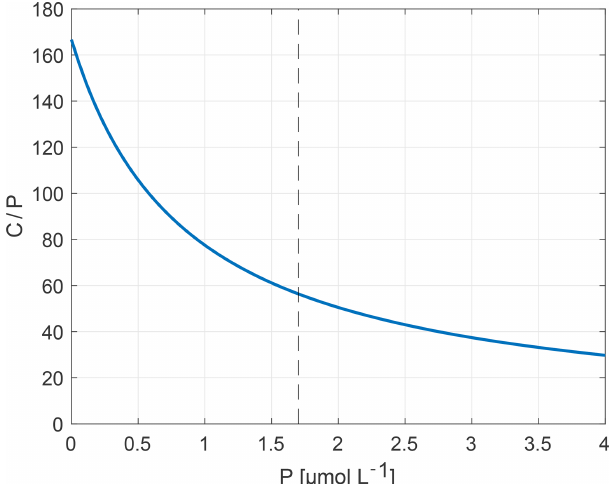
Figure 1. Flexible stoichiometry C / P ( y axis) dependent on the P concentration (µmolL − 1 ) ( x axis), as described by Eq. (1). Here, we extend the relationship beyond the observational interval 0– 1.7µmolL − 1 (bounded by dashed line) which forms the basis of the relation derived by Galbraith and Martiny